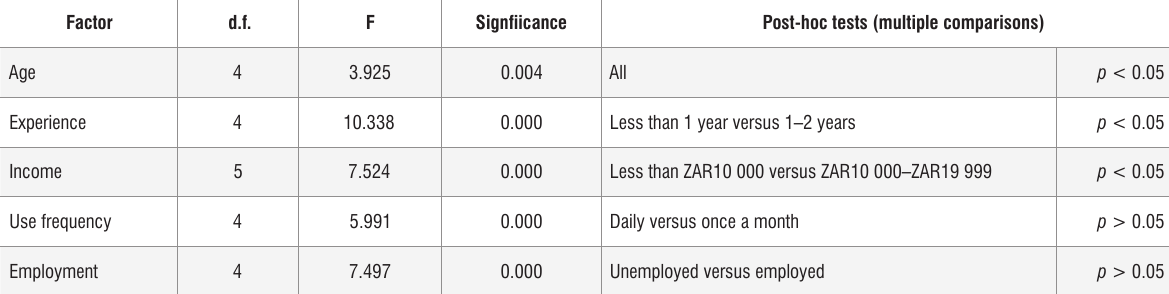
Table 5: One-way ANOVA of system usability scale (SUS) scores versus moderating factors